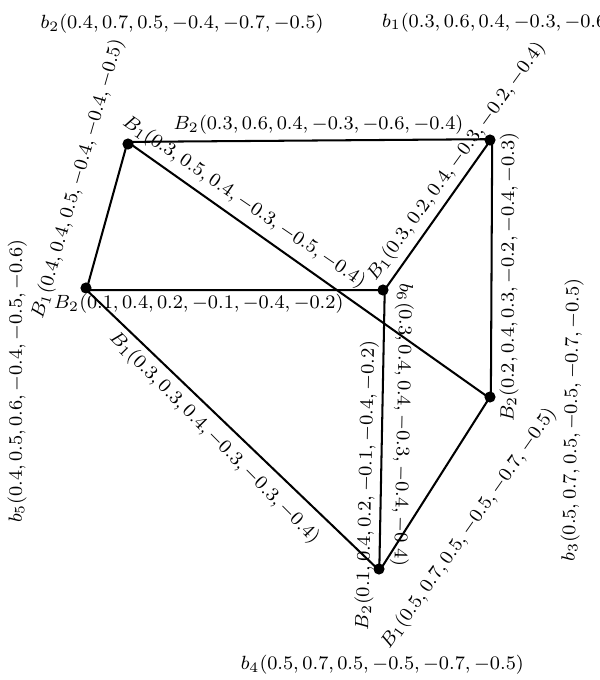
Figure 6. A BSVNGS ˇ G bn = ( B , B 1 , B 2 ) Figure 2.6: A BSVNGS ˇ G